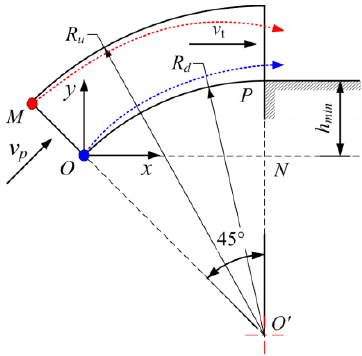
Figure 8. Design scheme of the throwing arc segment.